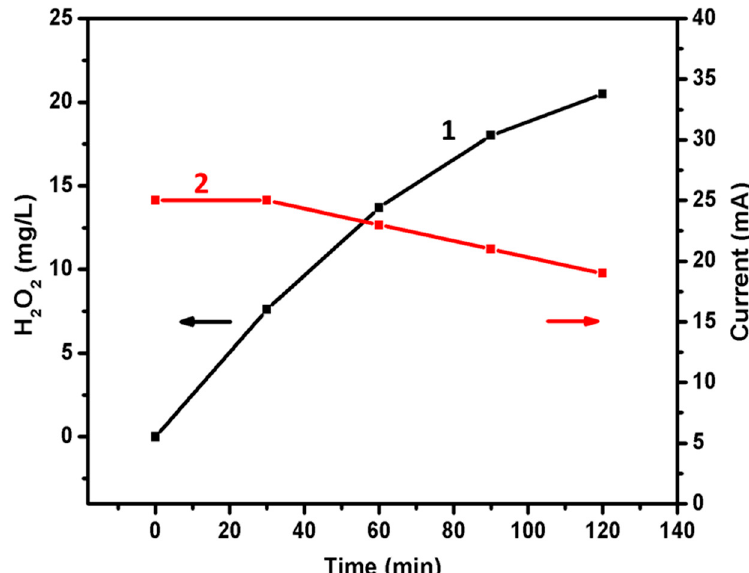
Figure 8. Photoelectrocatalytic hydrogen peroxide production using the reactor of Figure 2, equipped with a WO 3 photoanode. The counter electrode was a carbon cloth covered (one side) with mesoporous carbon. The active area of the photoanode and the counter electrode was 15 cm 2 (3 cm × 5 cm). The electrolyte was 0.5 M Na 2 SO 4 . The same electrolyte filled both reactor compartments; however, 5% v/v ethanol was added into the electrolyte of the anode compartment. Curve 1 displays hydrogen peroxide cumulative production, and curve 2, the corresponding photocurrent as a function of time. The applied bias was 1.0 V vs. Ag/AgCl. All of the data have been recorded with 2% error.